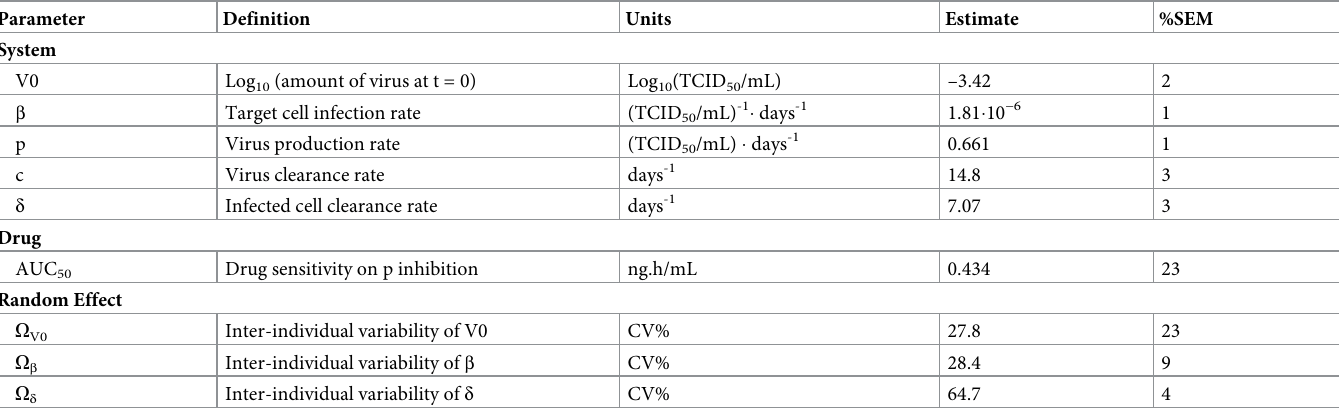
Table 1. Parameter estimates of the within-host pharmacokinetic–viral kinetic model.